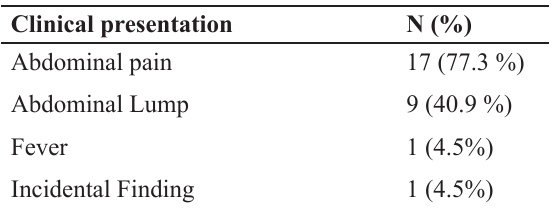
Table 1. Clinical presentation of the patients with